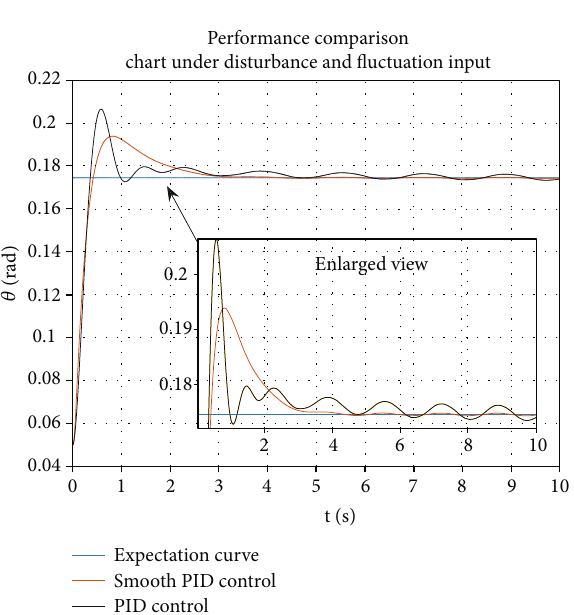
Figure 3: Performance comparisons under disturbance and fl uctuation control